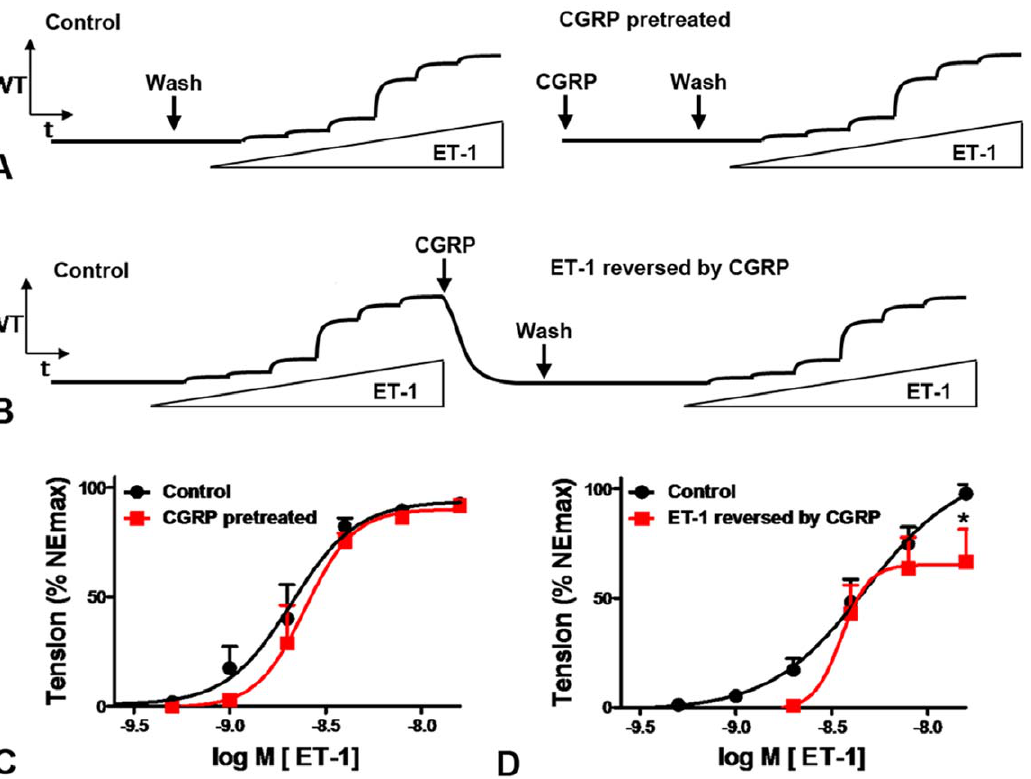
Figure 5. Unaltered arterial contractile responses to ET-1 (0.25–16 nM) following exposure to CGRP. A, schematic tracings of active wall tension (WT) versus time (t) illustrating contractile reponses to ET-1 (0.25–16 nM) in arteries transiently treated with (right) or without (left) CGRP (100 nM). B, schematic tracing of active wall tension (WT) versus time (t) illustrating initial ET-1 effects which were reversed by CGRP before a second concentration response curve was generated. C: Effect of ET-1 (0.25–16 nM) in arteries pre-treated with CGRP (100 nM, during 16 min). D: Effect of